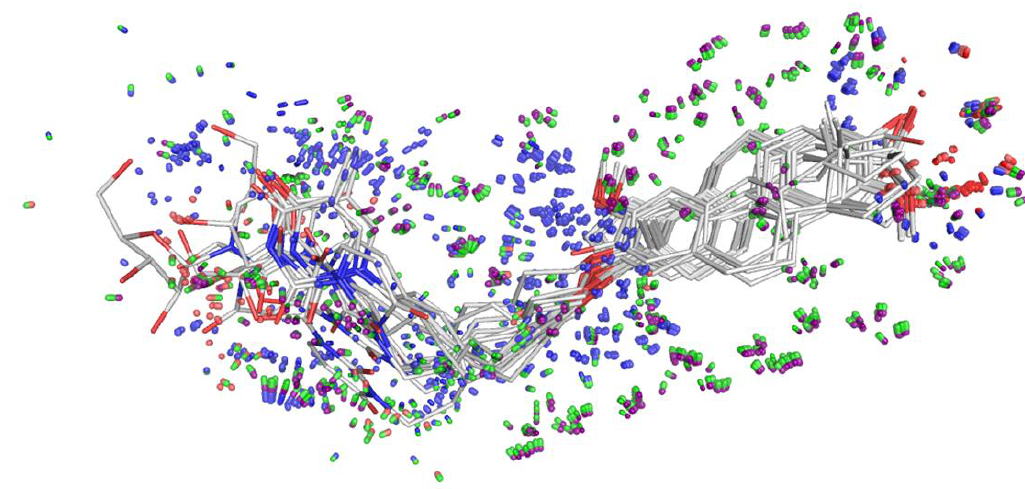
Figure 9. Alignment of molecules (line) and pocket-field (50% transparent stick). The pocket-field: sticks colored purple—coulombic response; green—steric; red—acceptor; blue—donor constructed by using ligand structure and MCF-7 activity information. Image generated by pymol [43].